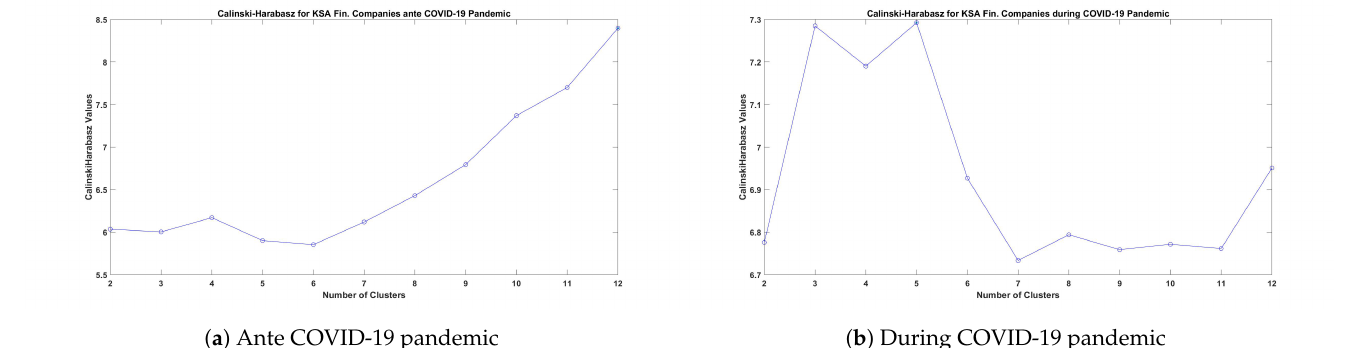
Figure 8. Calinski–Harabasz Index with Ward linkage. The figure to the left shows no clear-cut result on the number of clusters. The figure to the right shows that the optimal number of clusters is either 3 or 5.